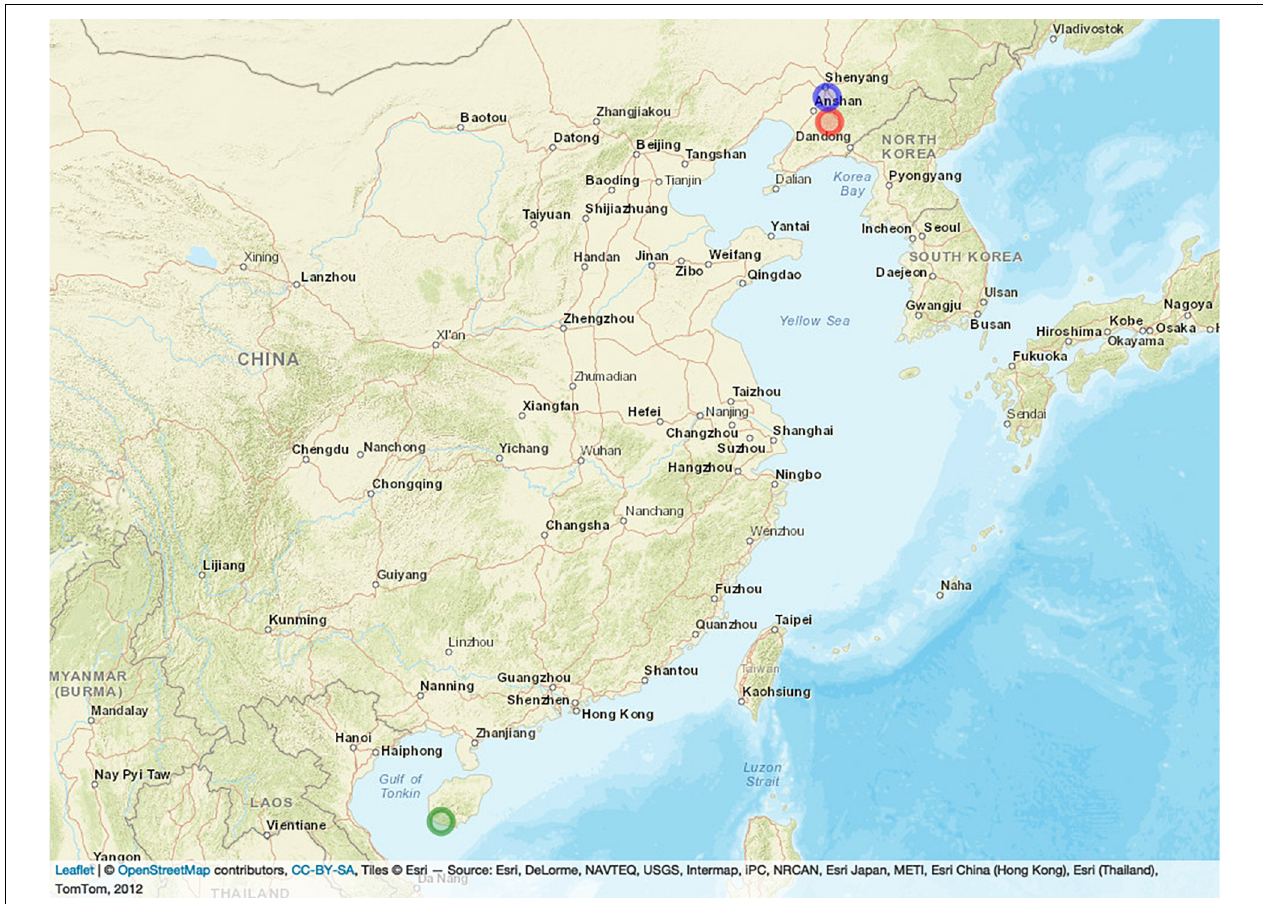
FIGURE 1 | Locations of the three field trials. The blue, red, and green circles represent SN, SY, and HN,